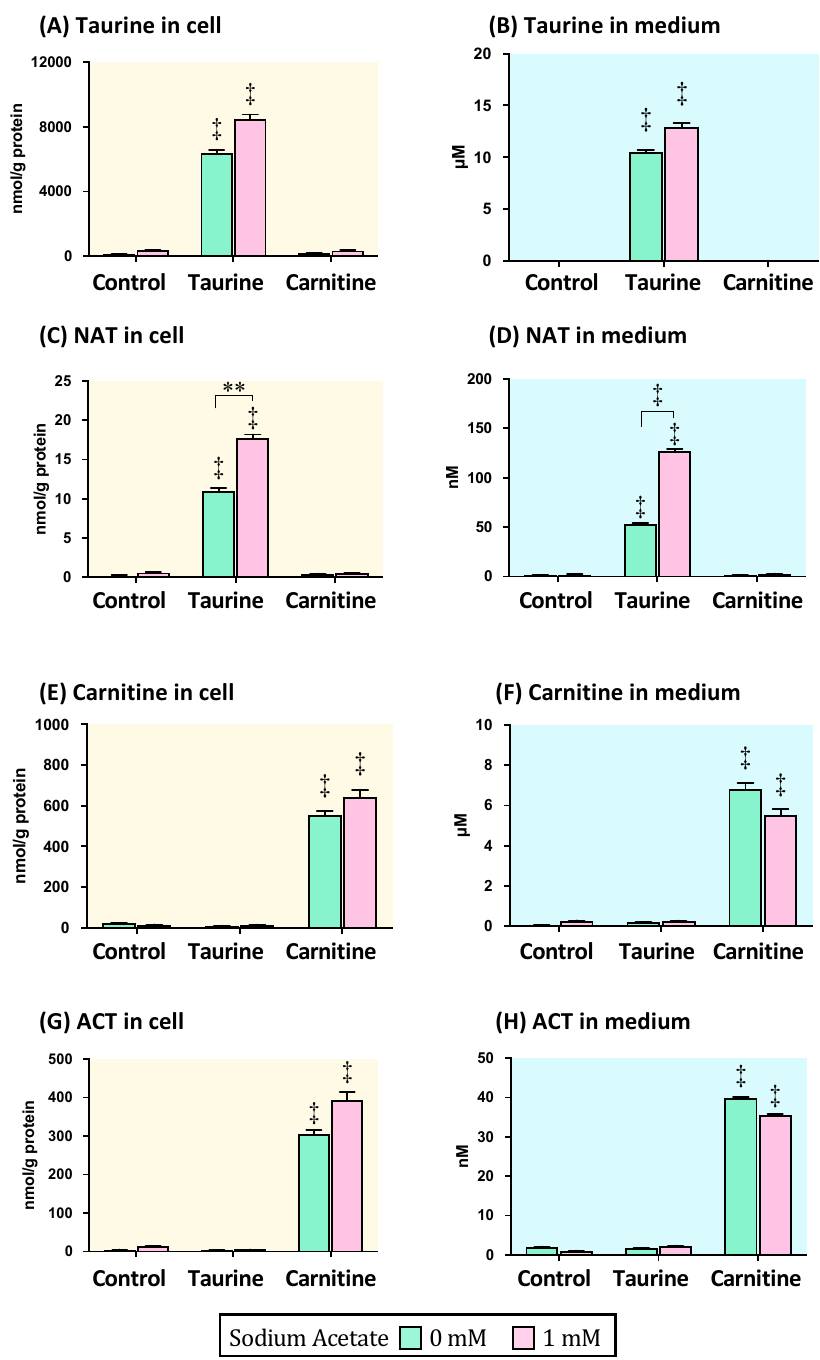
Figure 3. Taurine, carnitine, and its acetylated forms (NAT and ACT) in the myotube cell and culture medium after the treatments of taurine, carnitine, and acetate. The myotubes were treated with either 20 mM taurine or 300 µM carnitine for 24 h, and then exposed to 1 mM sodium acetate for 24 h. Thereafter, taurine, NAT, carnitine, and ACT concentrations in the cell ( A , C , E , G ) and culture medium ( B , D , F , H ) were measured. The data shown refer to the mean ± SEM. ** p < 0.01 and ‡ p < 0.0001 show the significant differences analyzed by the two-way ANOVA multiple comparison test. The symbols in the columns without bars show the significant difference compared to the respective control without taurine or carnitine treatment. Abbreviations: NAT; N -acetyltaurine, ACT; acetyl- carnitine.